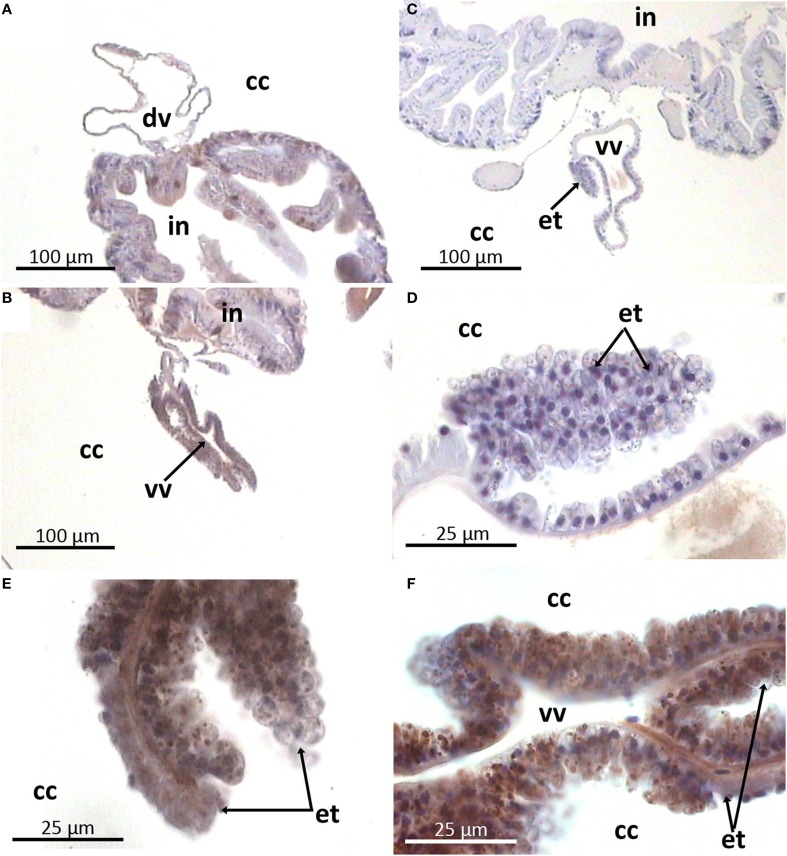
Arenicin-positive immunoreactivity of lugworm vascular system. A,B: general view of dorsal and ventral vessels respectively; E,F: extravasal tissue; C,D: negative controls; cc, coelomic cavity; dv, dorsal vessel; in, intestine; et, extravasal tissue; vv, ventral vessel.